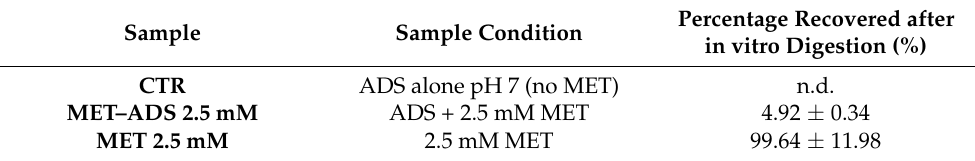
Table 2. Methionine percentage quantified after in vitro digestion. Results are presented as percent- age of the methionine initial dosage recovered (%) after in vitro